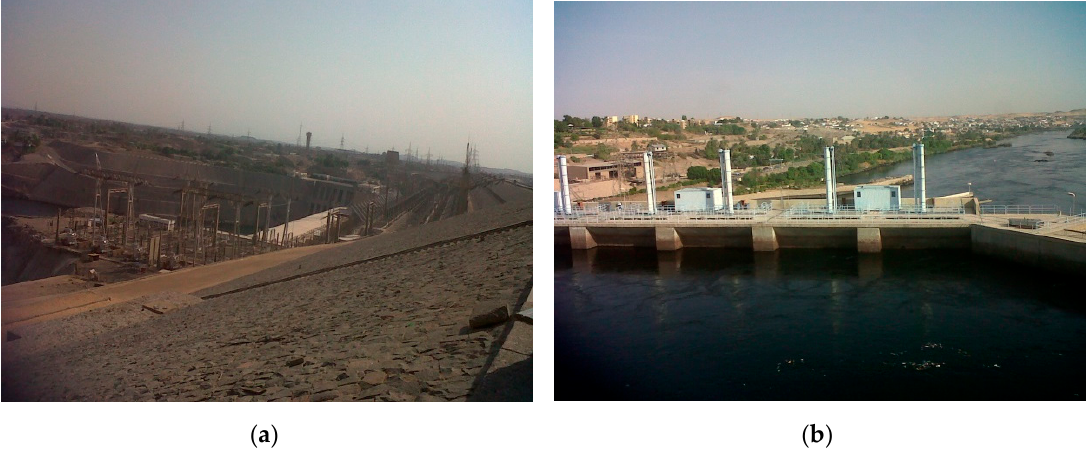
Figure 24. Aswan dam in Egypt: ( a ) view of today; and ( b ) past view (Photos by M. Salgot).